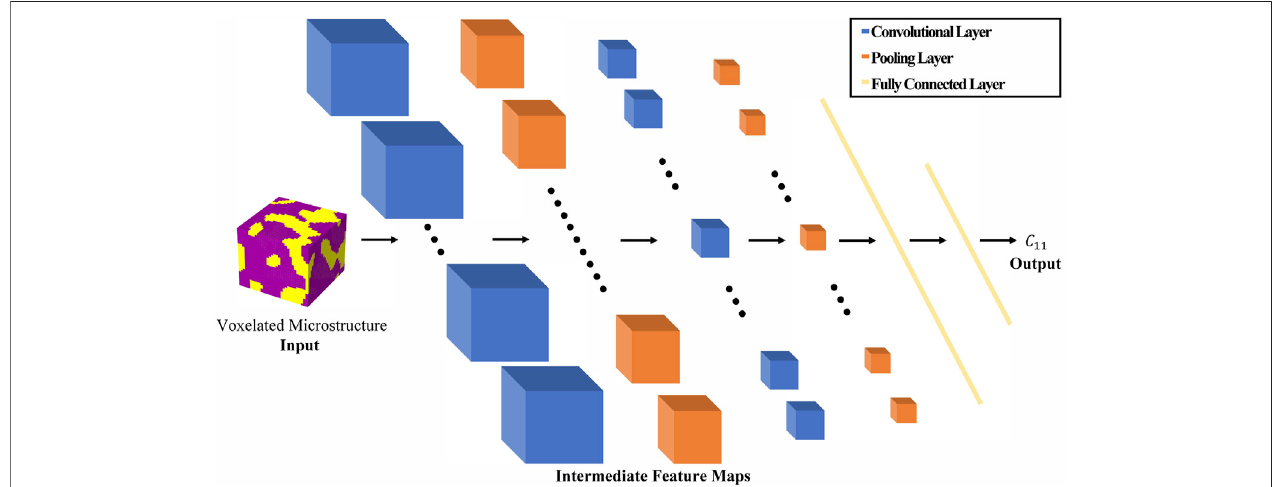
FIGURE 1 | Schematic of a typical CNN architecture consisting of convolutional layers, pooling layers, and fully connected